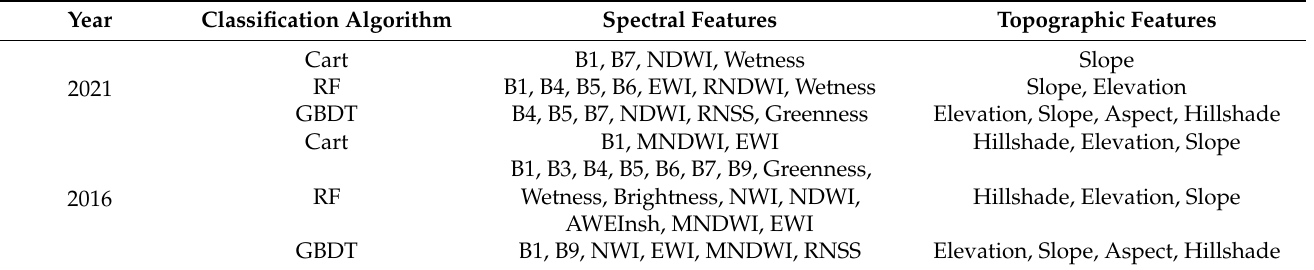
Table 3. Extraction feature selection of the Tibetan Plateau lakes with different classification methods in each year.